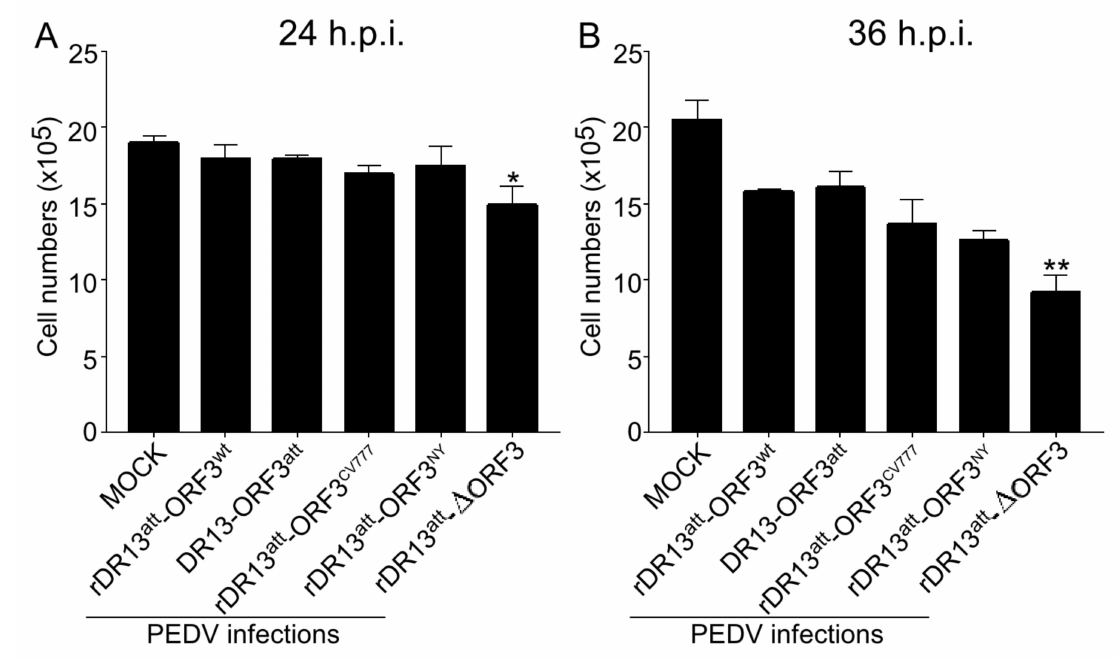
Figure 4. Viable Vero cell counts after infection with rPEDVs and DR13 att . Vero cells were mock-infected or infected with rDR13 att -ORF3 wt , rDR13 att -ORF3 CV777 , rDR13 att -ORF3 NY , rDR13 att - ∆ ORF3, and DR13 att at a MOI of 0.1. The number of live cells was counted at 24 h.p.i. (in A ) and 36 h.p.i. (in B ). Data are represented as the mean ± SD from three parallel tests. Symbols * and ** indicate the di ff erence between rDR13 att - ∆ ORF3 and the other viruses is significant ( p < 0.05) or very significant ( p < 0.01),